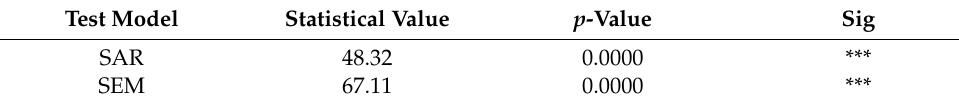
Table 6. Results of spatial panel model test. Test